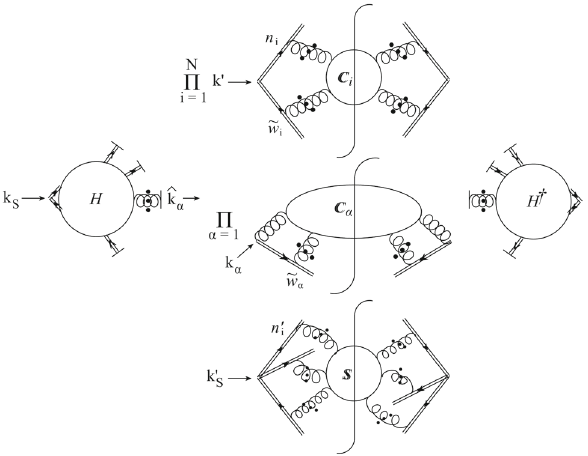
Fig. 2 Leading regions for the soft factor, S N − h , at small b T